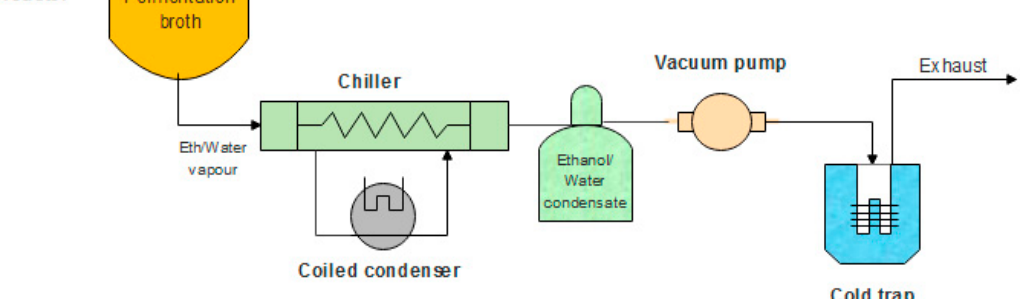
Figure 4. Setup of fermentation process coupled with the vacuum stripping system for ethanol recovery. Table 3. Review of studies about ethanol removal using vacuum fermentation (C: Substrate concentration, P: vacuum pressure, T: